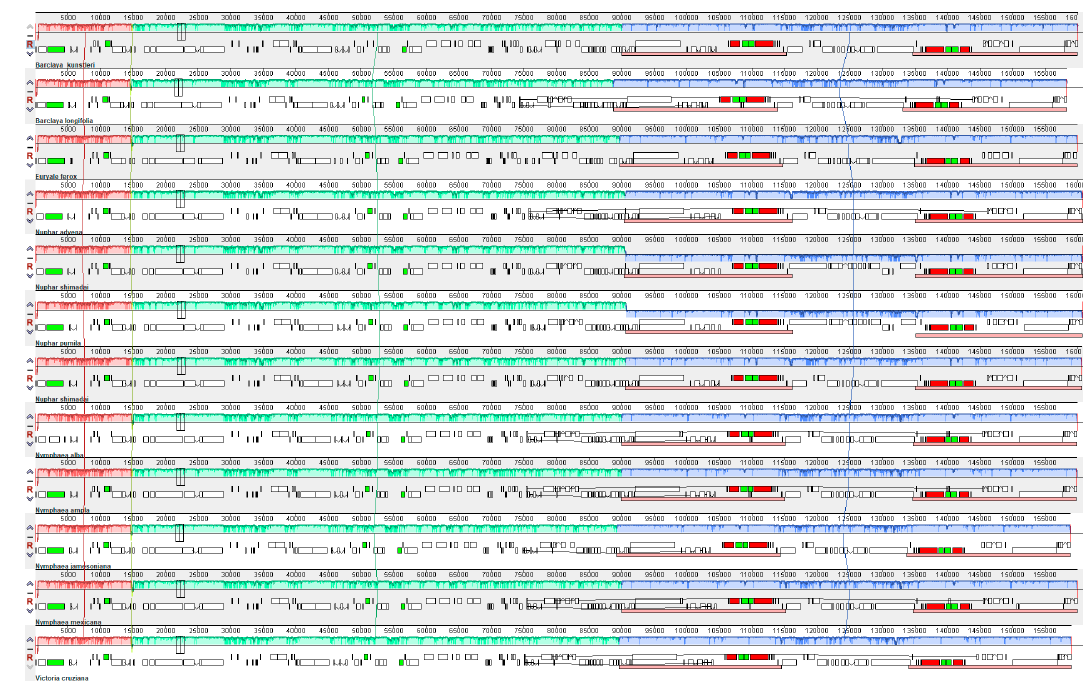
Figure 5. Mauve software alignment of the whole chloroplast genome of 12 species of Nymphaeaceae. Local collinear blocks representing identical gene clusters are depicted by the same color and are connected by lines.